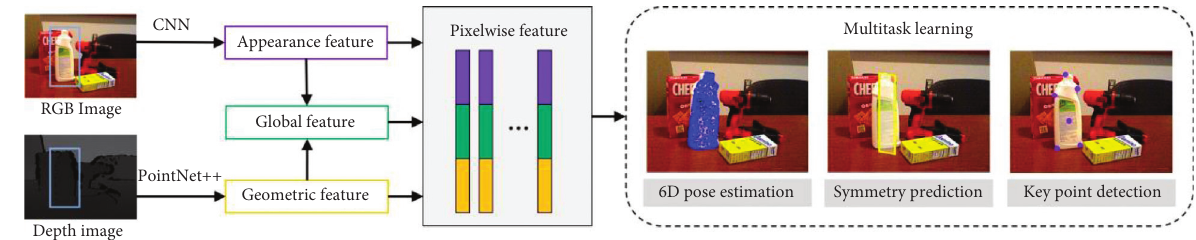
Figure 1: Architecture of the symmetry-aware object pose estimation network.